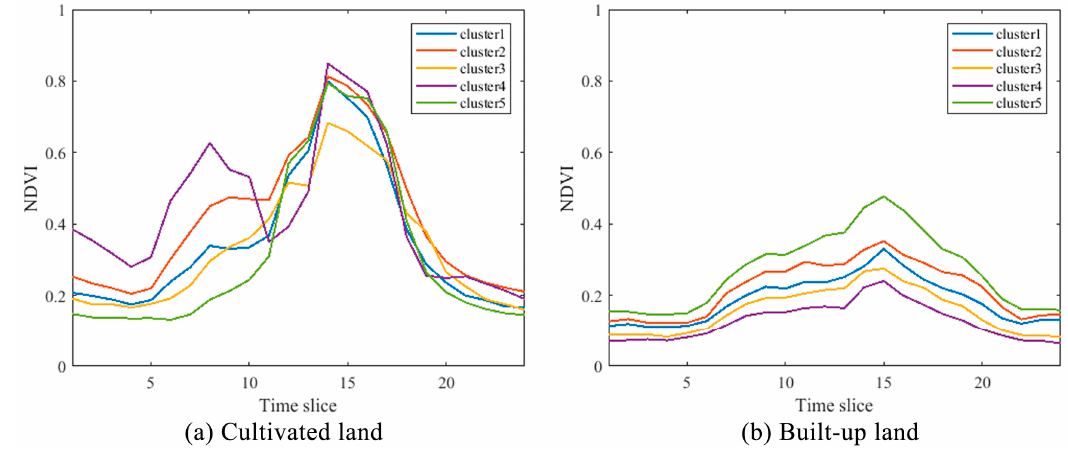
Figure 7. The averaged NDVI profiles for cultivated land and built-up land derived from the training time series, where ( a ) is for cultivated land and ( b ) is for built-up land.